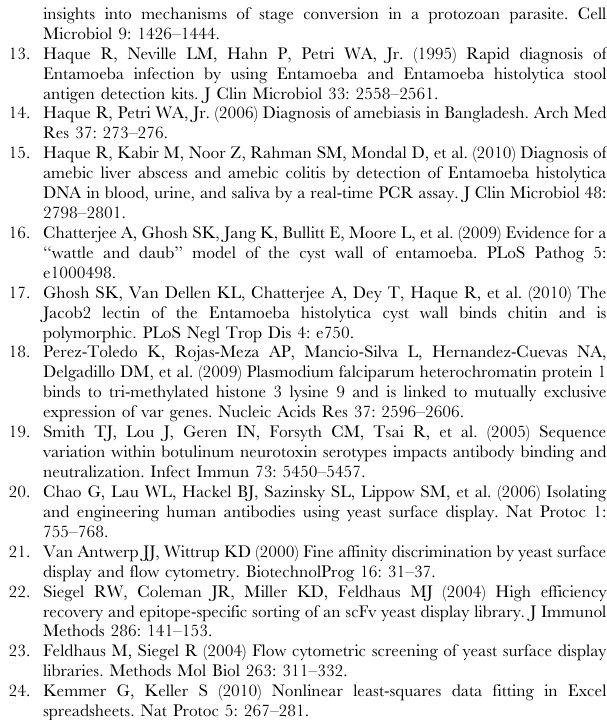
Figure S1 Pre- and post-lyophilization activity determi- nation with multiple yeast-scFv clones. Yeast clones were tested for their ability to bind antigen following lyophilization. One hundred microliters of either fresh or lyophilized/rehydrated yeast were stained first for c- myc -FITC expression ( x -axis) followed by binding to cognate antigen and to a non-cognate control (100 nM antigen concentration). The name of the clone is indicated on the far left column. The non-cognate and cognate antigens used to generate the flow cytometric plots are indicated on the right of the figure. Binding to antigen is indicated by an increase in PE fluorescence ( y -axis). Clones 350-10 and 780-18 are myc -negative due to premature stop codons following the scFv gene. However, these clones appeared to bind antigen before and after lyophilization.